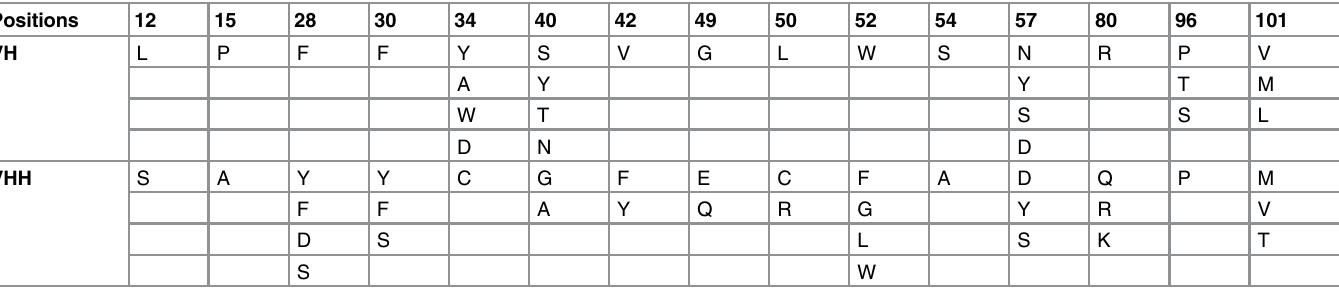
Table 2. Specific amino acids differences between VH and VHH clones of three camels. Positions